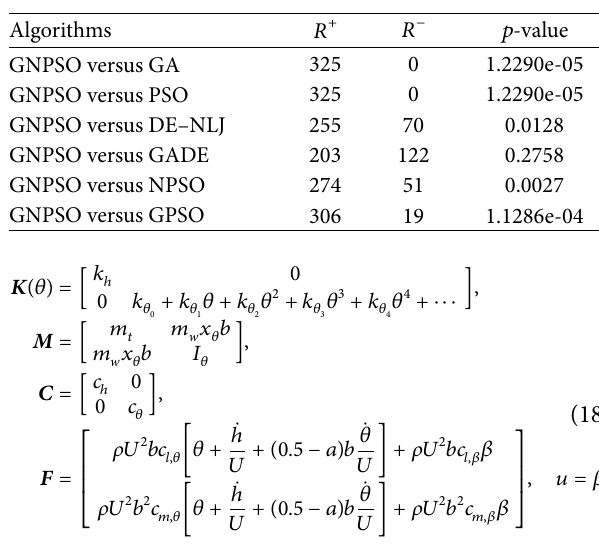
Table 4: Wilcoxon signed ranks test results for the control perfor- mance of linear wing vibration control system obtained by different